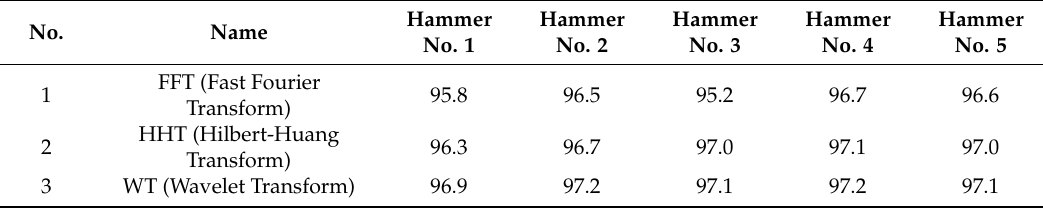
Table 6. The success rate (%) in different methods.